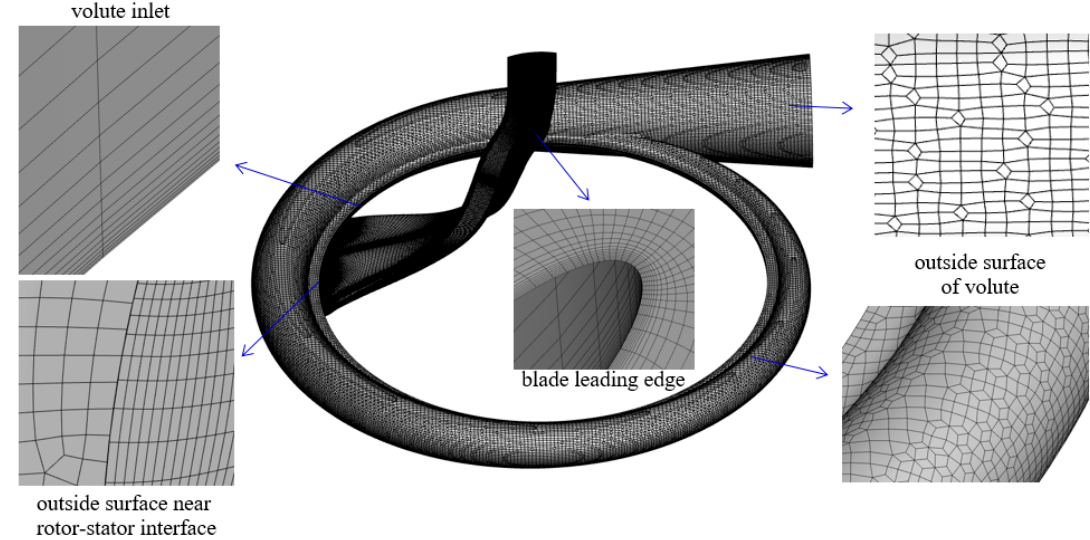
Figure 9. The solid model of the optimal compressor stage: ( a ) Impeller; and ( b ) Volute.